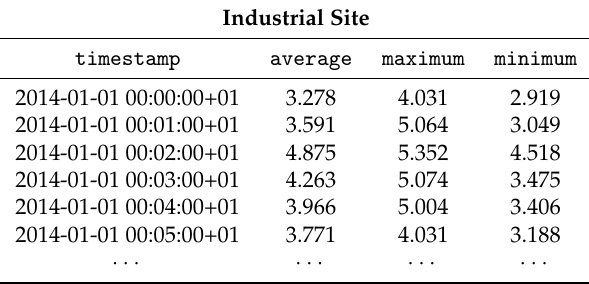
Table 1. Structure of the raw data from the industrial site (first six